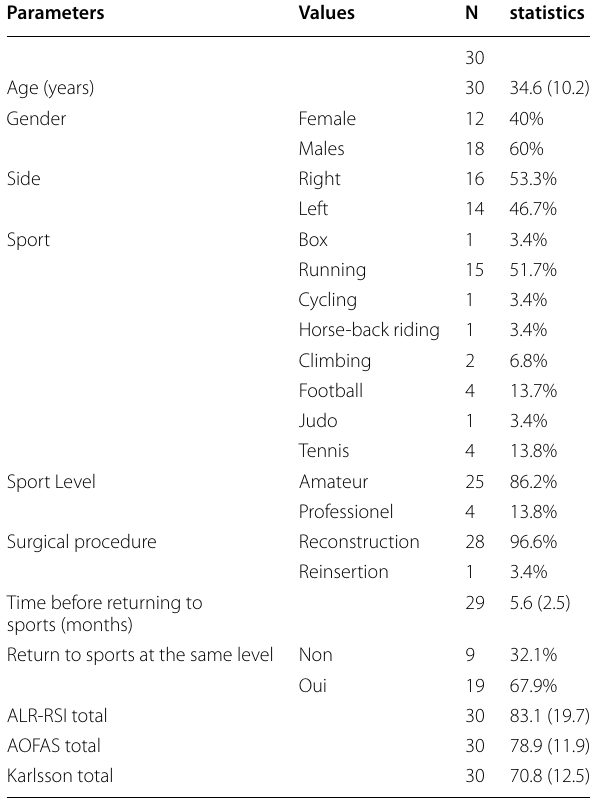
Table 1 Demographic presentation of the patient population